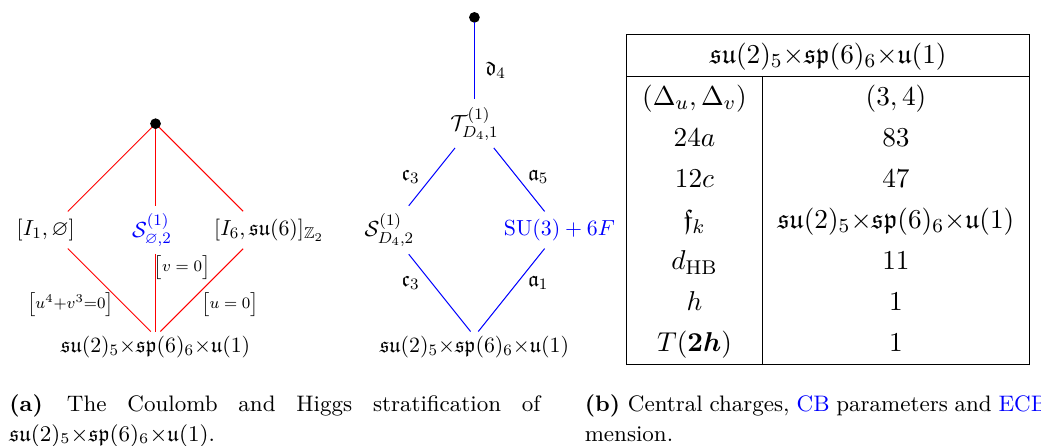
mension. Figure 18. Information about the su (2) 5 × sp (6) 6 × u (1) theory.